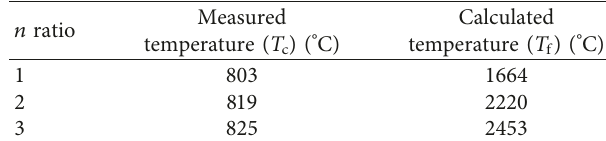
Table 2: Influence of n ratio on the maximum combustion temperature.